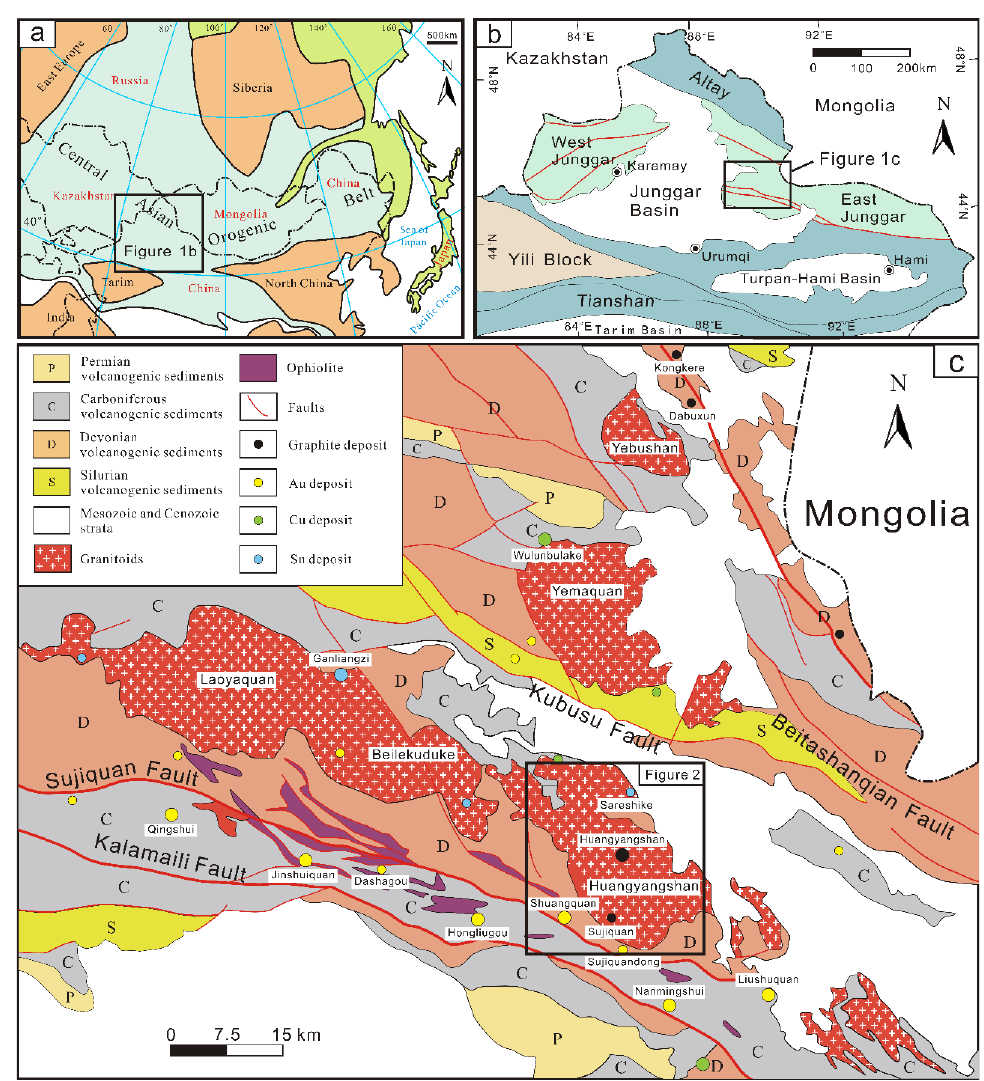
Figure 1. ( a ) Sketch map of the Central Asian Orogenic Belt (after [54]); ( b ) Geological map of the northern Xinjiang Province (after [38]); ( c ) Simplified geological map of the Kalamaili area, Eastern Junggar (modified after [19]).